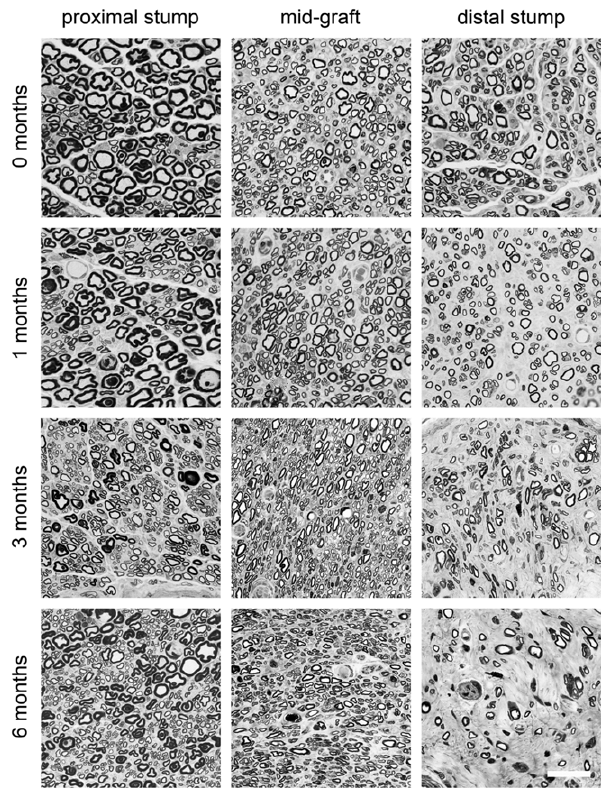
Figure 2. Toluidine blue stained myelinated axons in the proximal stumps, mid-graft regions and distal stumps of animals undergoing sciatic nerve injury followed by either immediate or delayed nerve repair (at the time points indicated) with a 10 mm graft. Note increase of number of small myelinated fibers in proximal stump in 3 months and 6 months groups. Scale bar=30 m m.